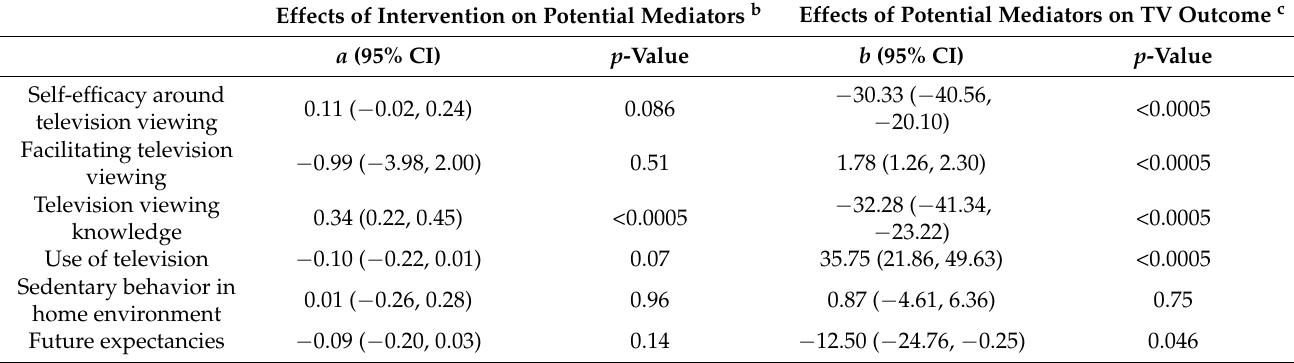
Table 3. Mediating pathways between the intervention group, potential mediators and children’s television viewing time a